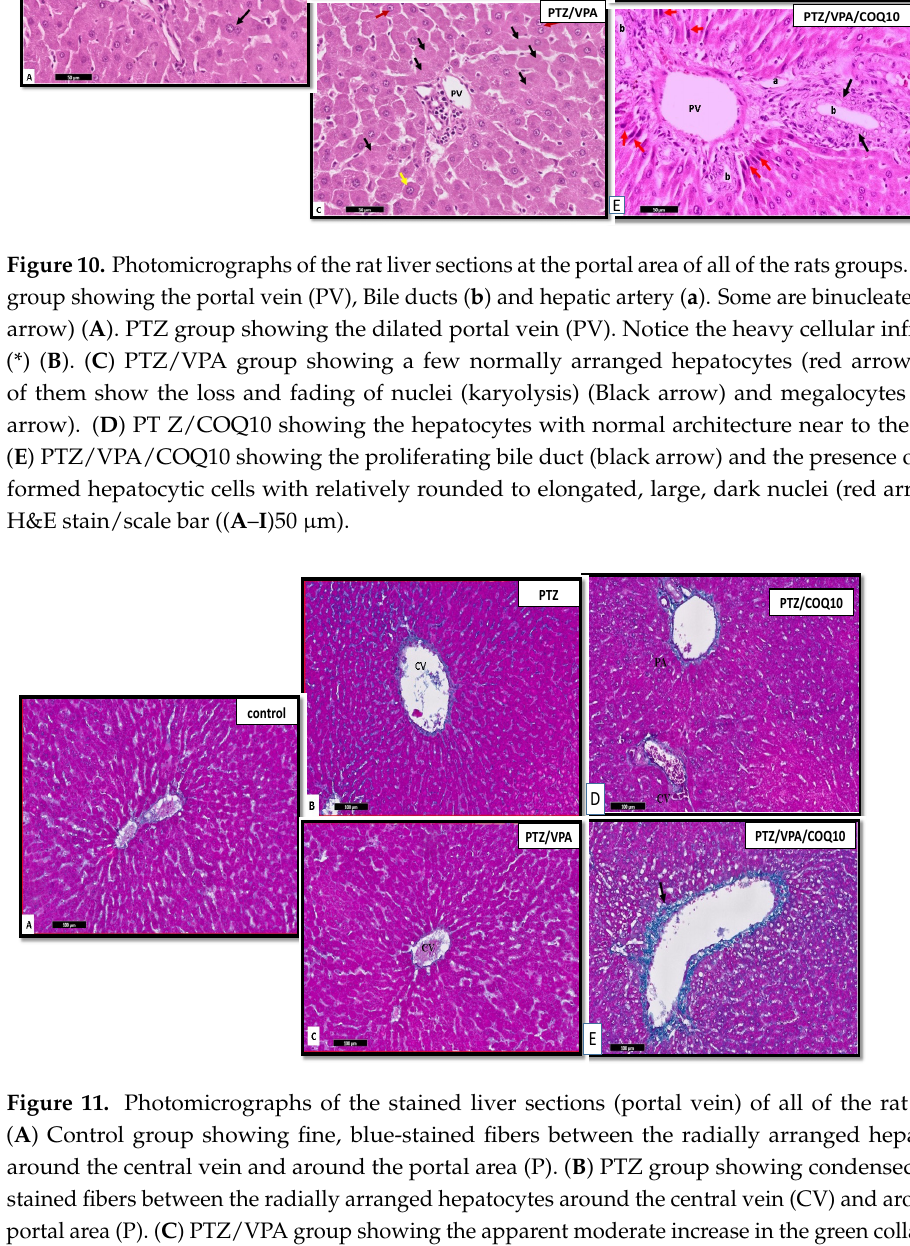
arrow). ( D ) PT Z/COQ10 showing the hepatocytes with normal architecture near to the control. ( E ) PTZ/VPA/COQ10 showing the proliferating bile duct (black arrow) and the presence of newly formed hepatocytic cells with relatively rounded to elongated, large, dark nuclei (red arrow) ( E ). H&E stain/scale bar (A ‐ I 50 μ m).